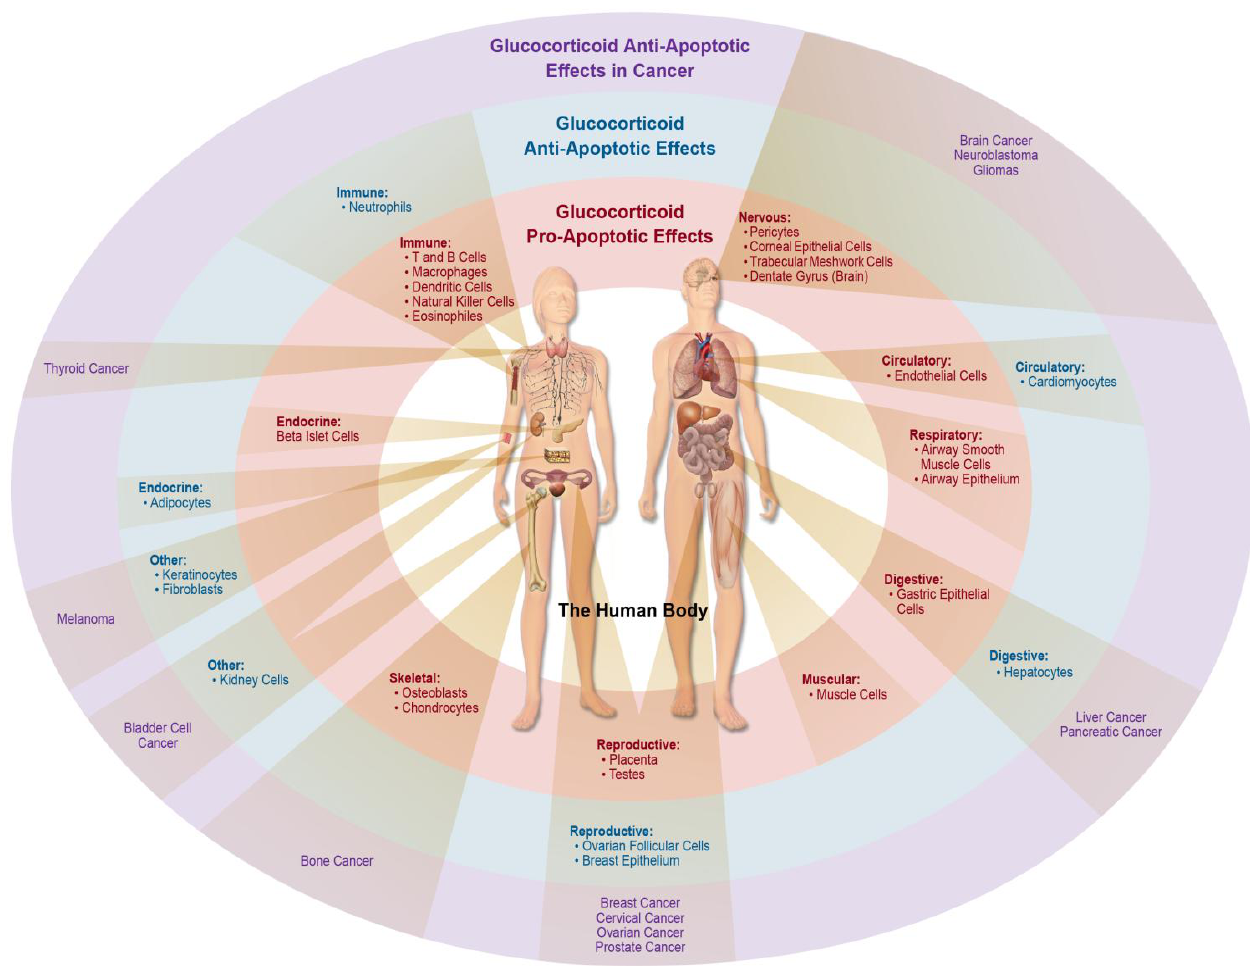
Figure 3. Tissue-specific effects of glucocorticoids on apoptosis in the human